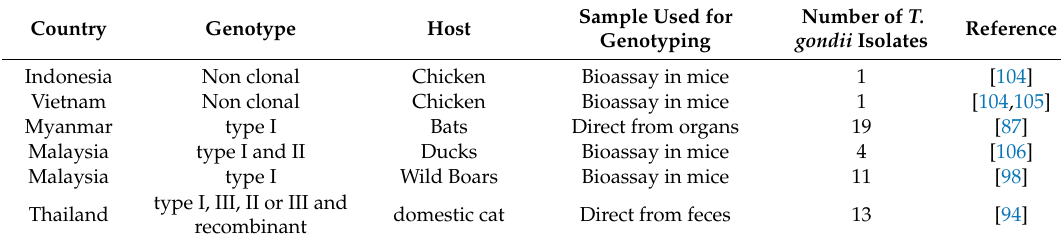
Table 7. Shows reported genotypes of T. gondii by polymerase chain reaction-restriction fragment length polymorphism PCR-RFLP in Malaysia other countries in Southeast